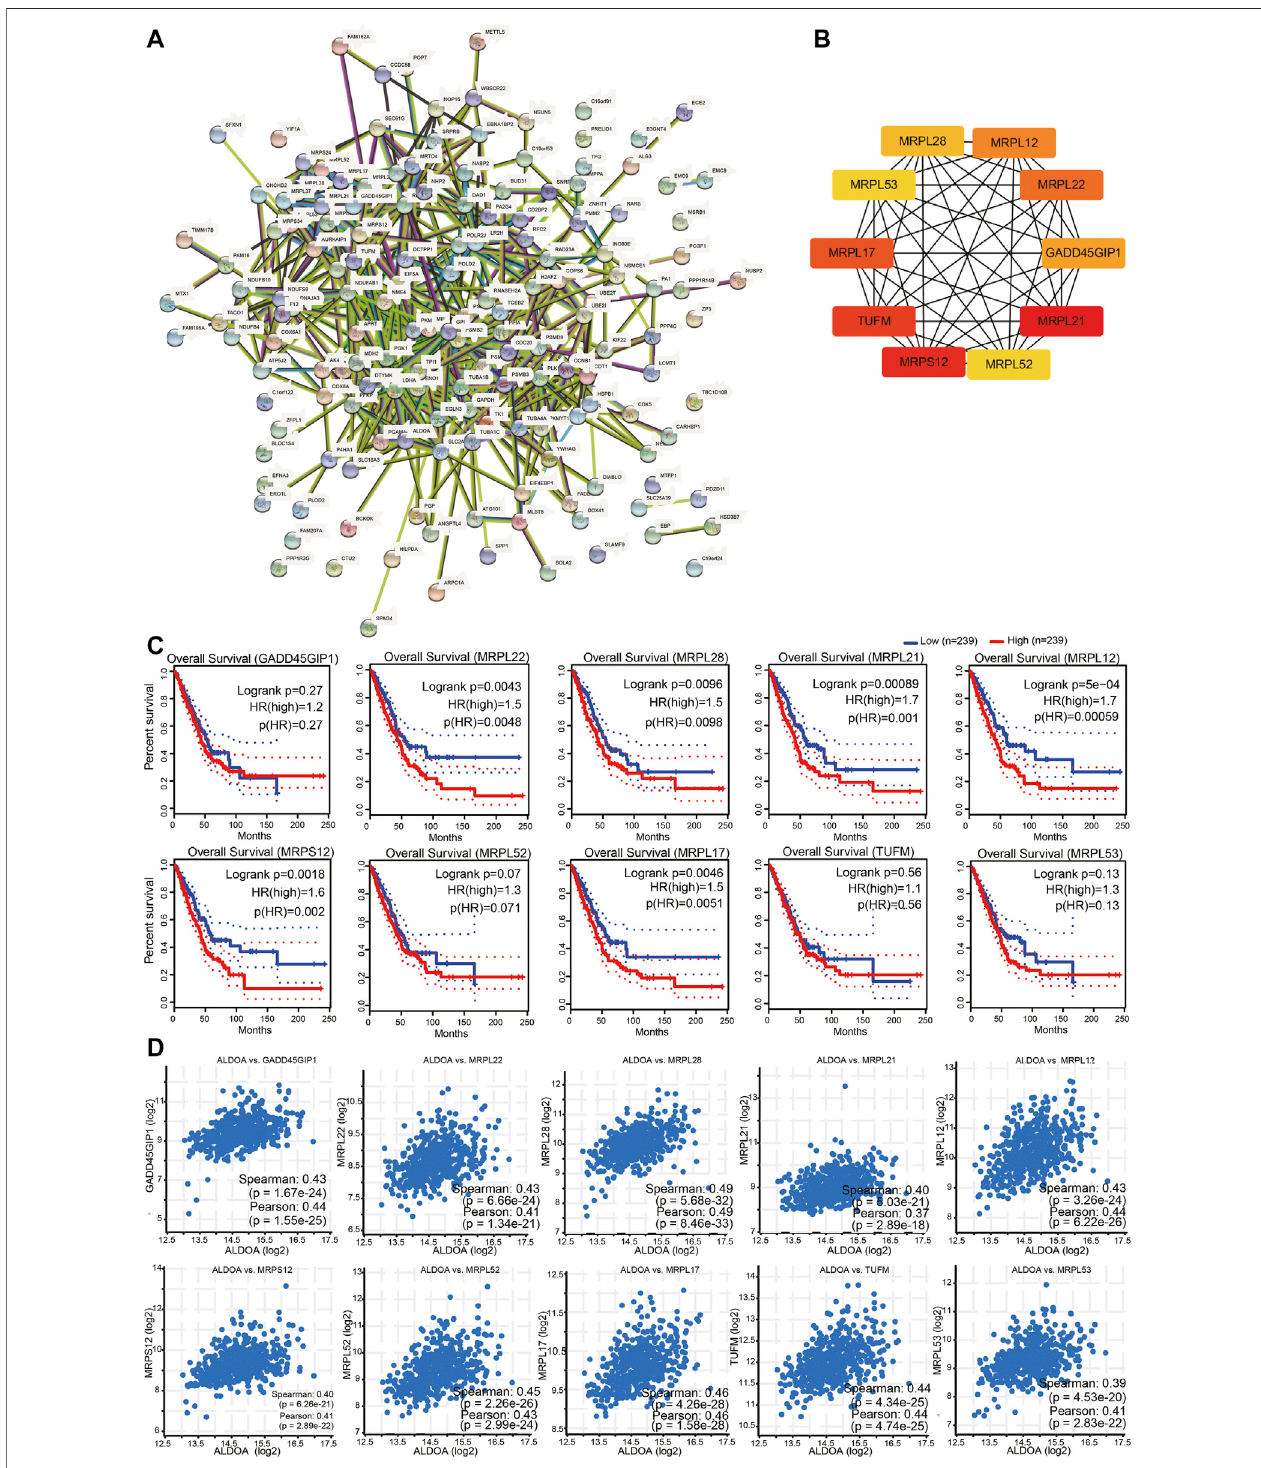
FIGURE9| ConstructionofPPInetworksandidenti fi cationofhubgenesamongco-expressedgenesofALDOA (A) ConstructionofPPInetworksbySTRINGwith 165 positively co-expressed genes of ALDOA (B) Identi fi cation of ten hub genes of ALDOA withcytoHubba tool in Cytoscape (C) Prognostic importance analyses of10 hub genes with GEPIA (D) Correlation between ALDOA and mRNA expression of 10 hub genes determined with c-BioPortal.